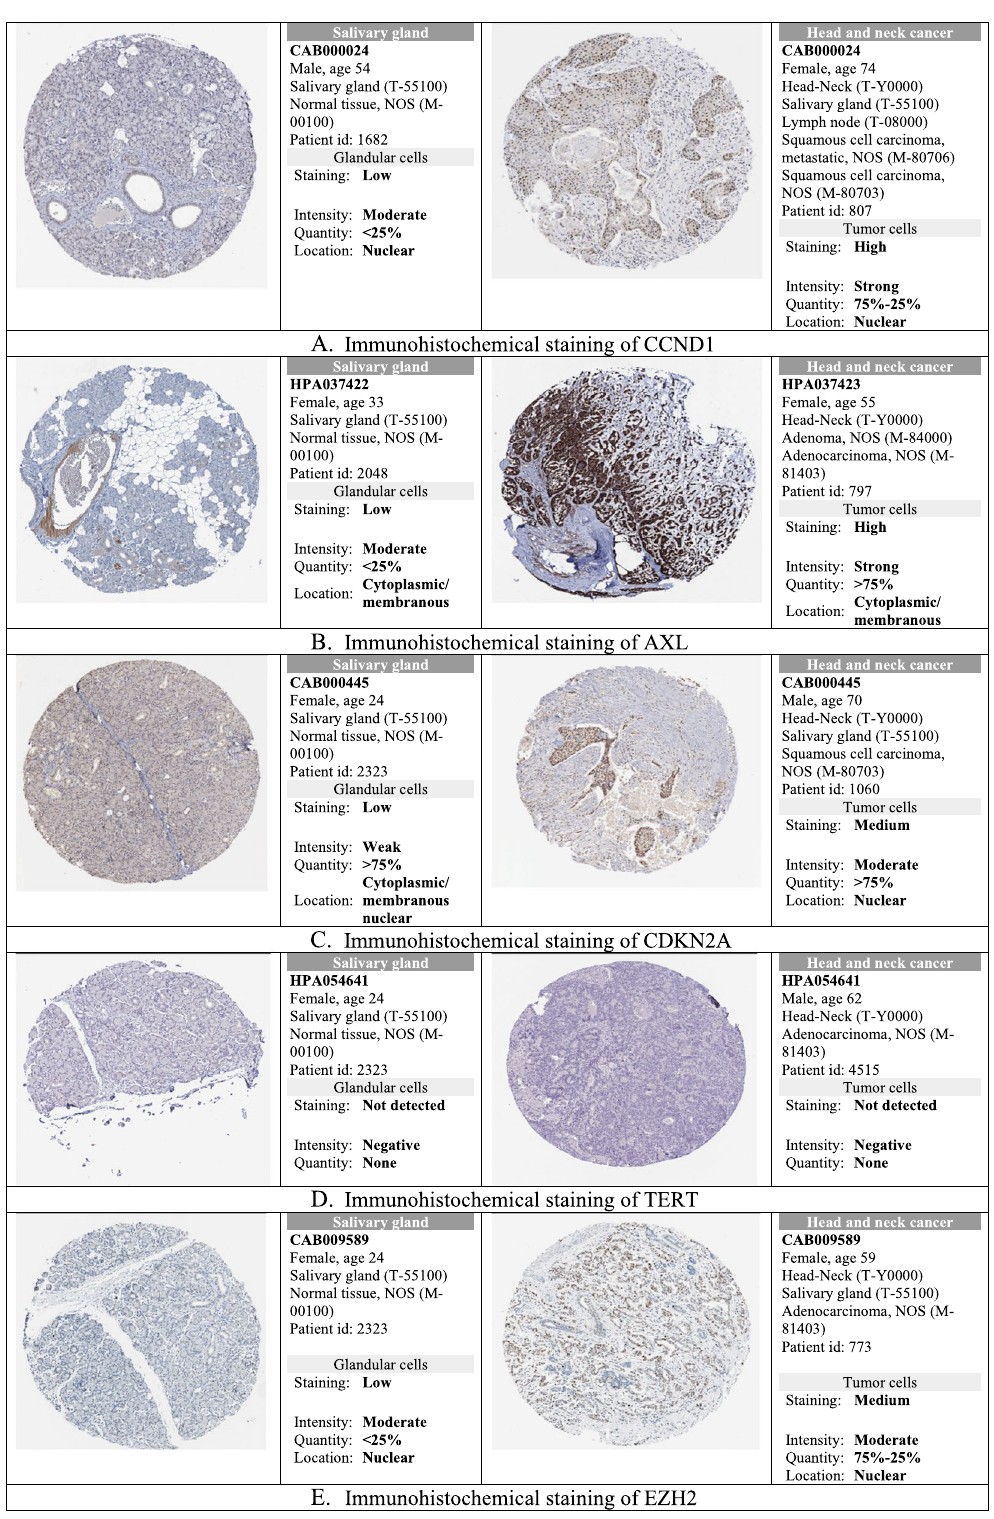
Fig. 6 Immunohistochemistry of significant hub genes. A Immunohistochemical staining of CCND1. B Immunohistochemical staining of AXL. C Immunohistochemical staining of CDKN2A. D Immunohistochemical staining of TERT. E Immunohistochemical staining of